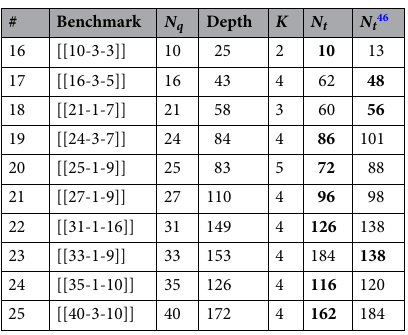
Table 4. Comparison the number of teleportations of proposed method ( N t ) with proposed approach of 46 on Circuits 16 to 25.